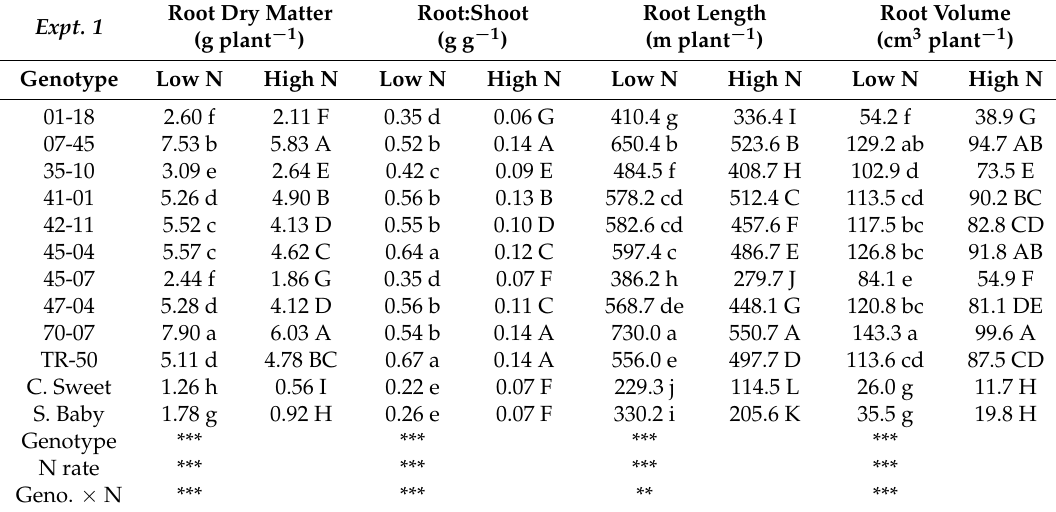
Table 2. Root dry matter, root:shoot ratio, root length and root volume of the ten bottle gourd genotypes and two watermelon cultivars grown under low (0.3 mM) and high (3.0 mM) N supply in Expt. 1 . Root Dry Matter Root:Shoot Root Length Expt. 1 (g plant − 1 ) (g g − 1 ) Genotype Low N High N Low N High N Low N High N